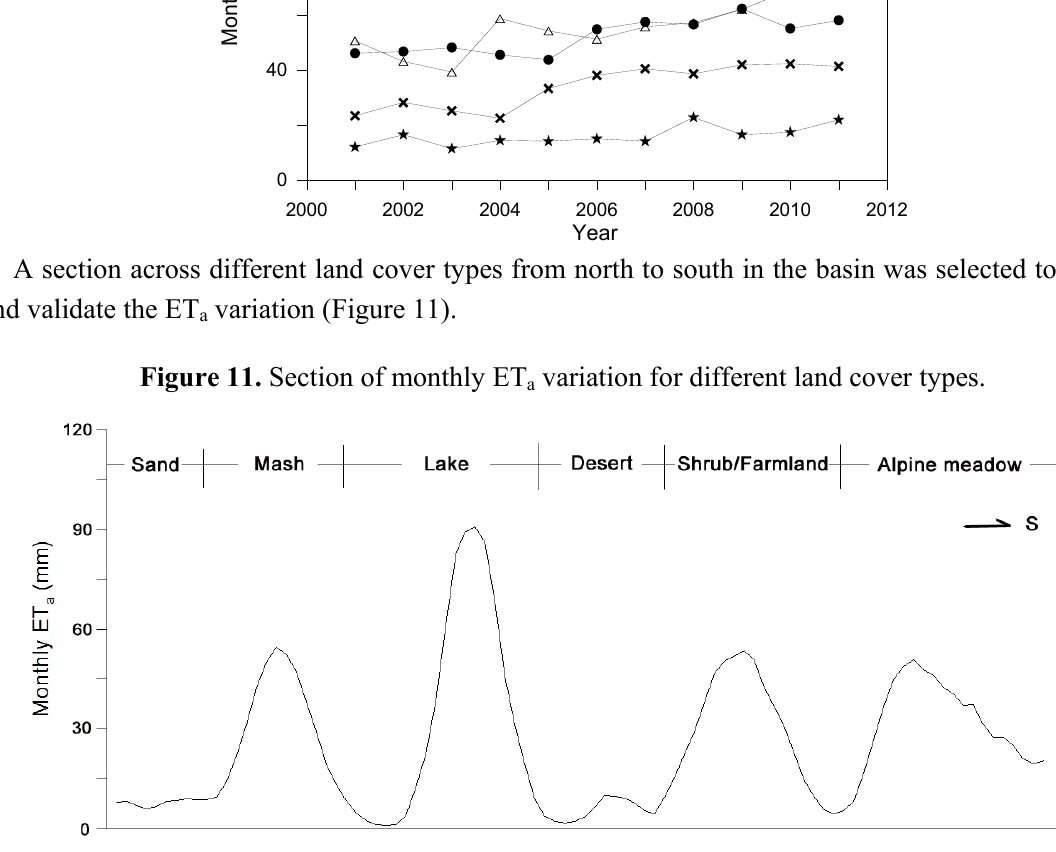
Figure 10. Monthly SEBS ET